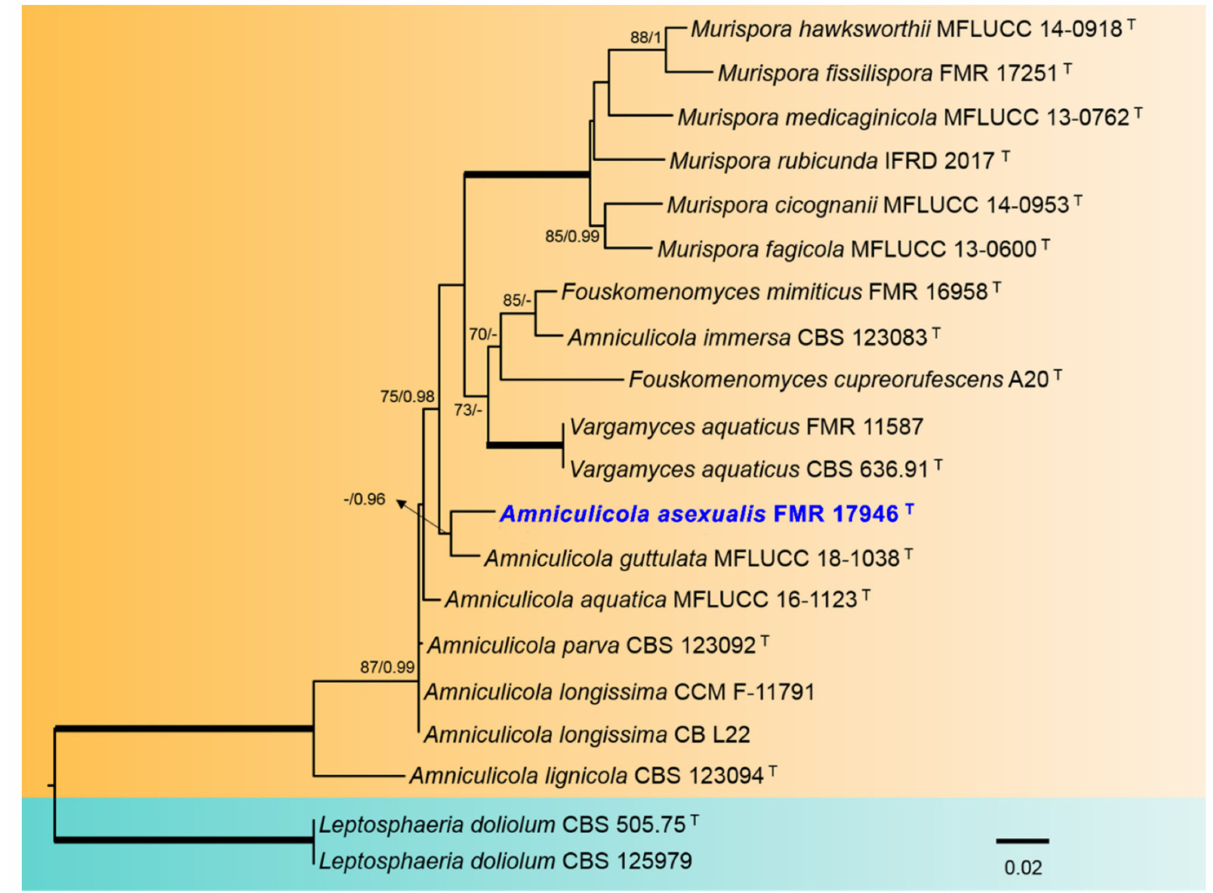
Figure 3. Phylogenetic tree inferred from an ML analysis based on a concatenated alignment of ITS and tef-1 sequences of 20 strains representing species in the Amniculicolaceae . The RAxML bootstrap support values (BS) above 70% and the Bayesian posterior probabilities (PP) above 0.95 are given at the nodes (BS/PP). Fully supported branches (100 BS/1 PP) are indicated in thicker lines. Newly proposed taxa are given in blue . Type strains are indicated by a superscript “T”. The tree was rooted with Leptosphaeria dolium CBS 505.75 and CBS 125979. Alignment length 1117